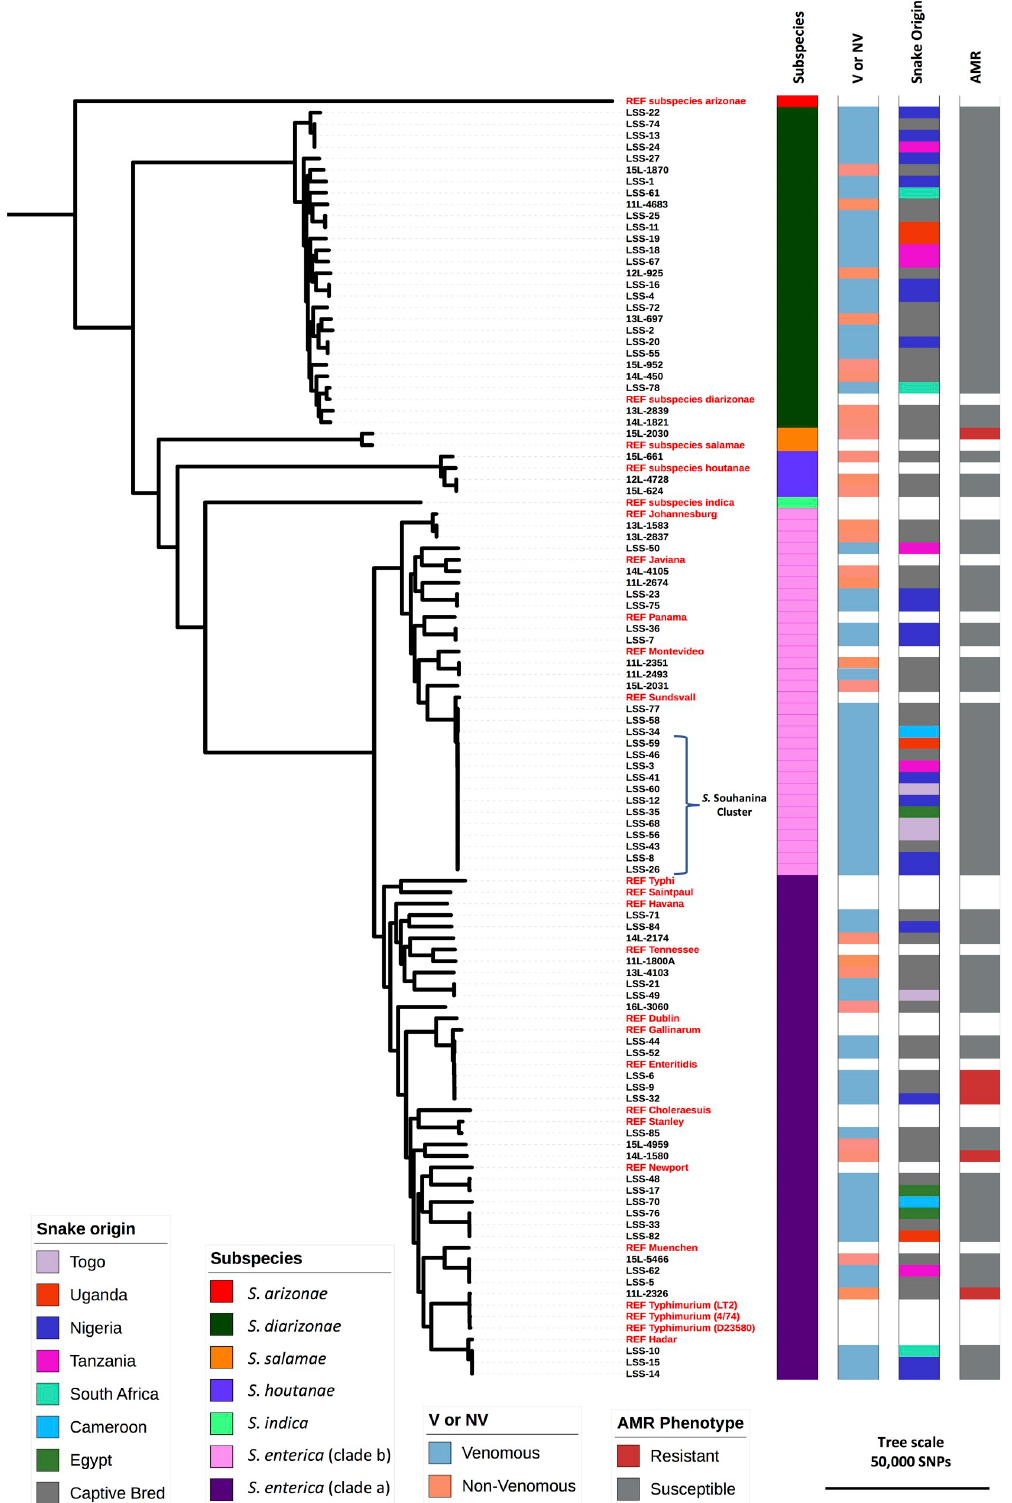
Fig 2. The diversity of Salmonella isolated from a collection of venomous snakes and non-venomous reptiles. Core genome maximum likelihood phylogenetic tree. The tree was rooted using S . bongori (S1 Fig). 25 contextual